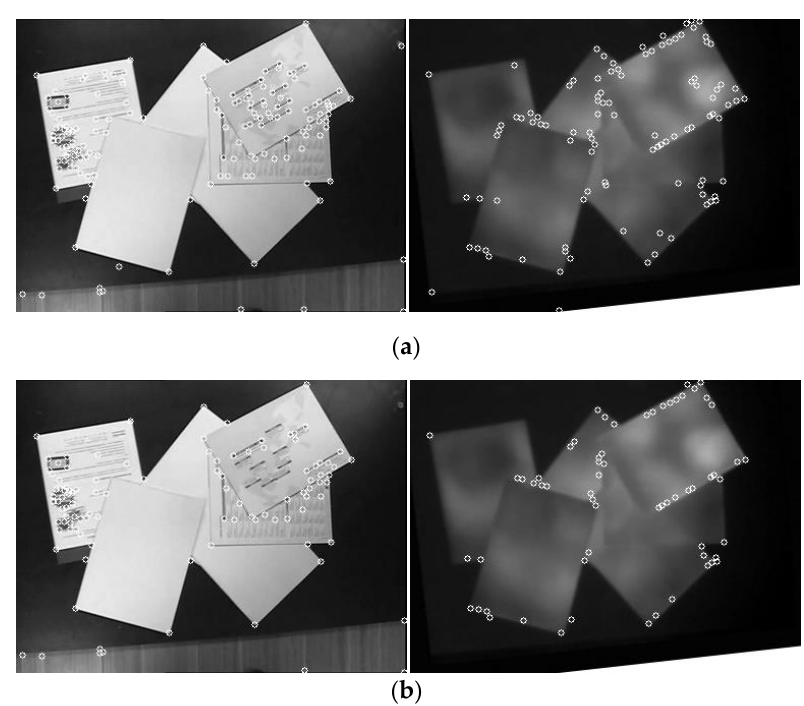
Figure 2. Example of common feature detection. ( a ) Harris corners. ( b ) Common feature points.